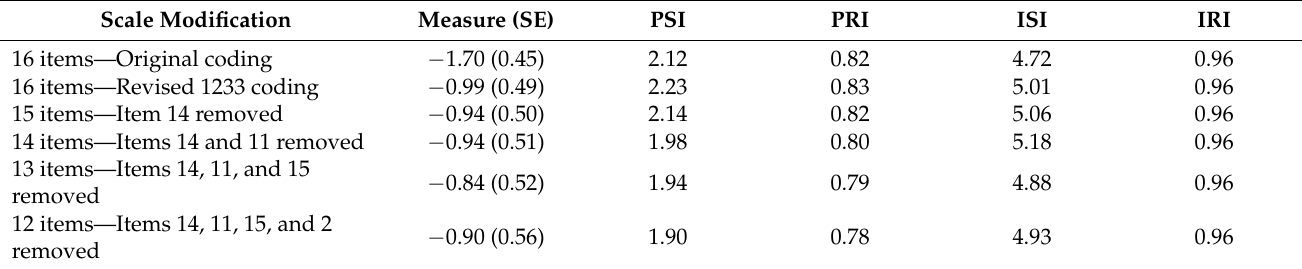
Table 3. Person and item measures, separation, and reliability indexes for six iterations of the Distress subscale of Strong Souls. Scale